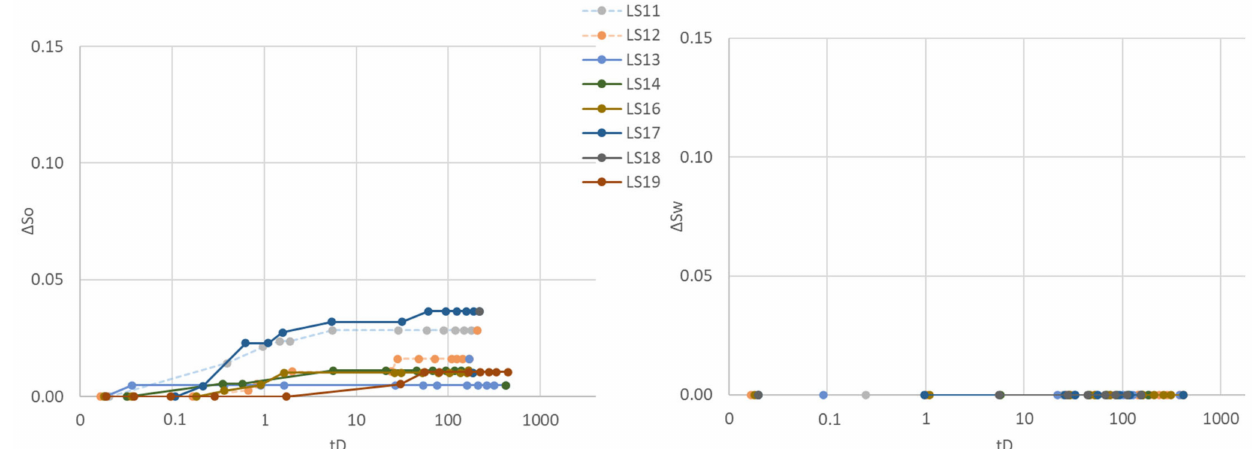
Figure 3. Spontaneous saturation development as functions of dimensionless time during imbibition. Cores were placed in imbibition cells with oil and brine, respectively, during the first Amott–Harvey cycle. ( Left ): Oil saturation ( ∆ S o ) during spontaneous oil imbibition, and ( Right ): Water saturation ( ∆ S w ) during spontaneous water imbibition. Note that the y -axis only represents a part of the mobile saturation range. The scale is kept constant for all cycles, to enable simple comparison of results.